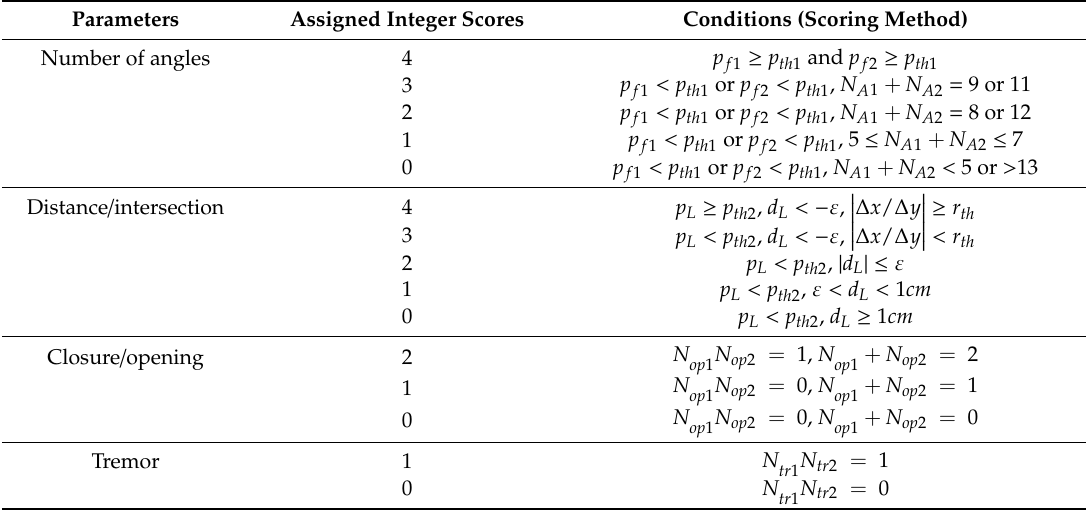
Table 3. Details for the assignment of